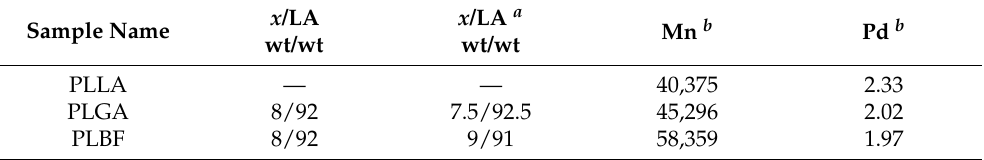
Table 1. Mechanical properties of PLLA/PLGA/PLBF modified atmosphere breathing membrane.